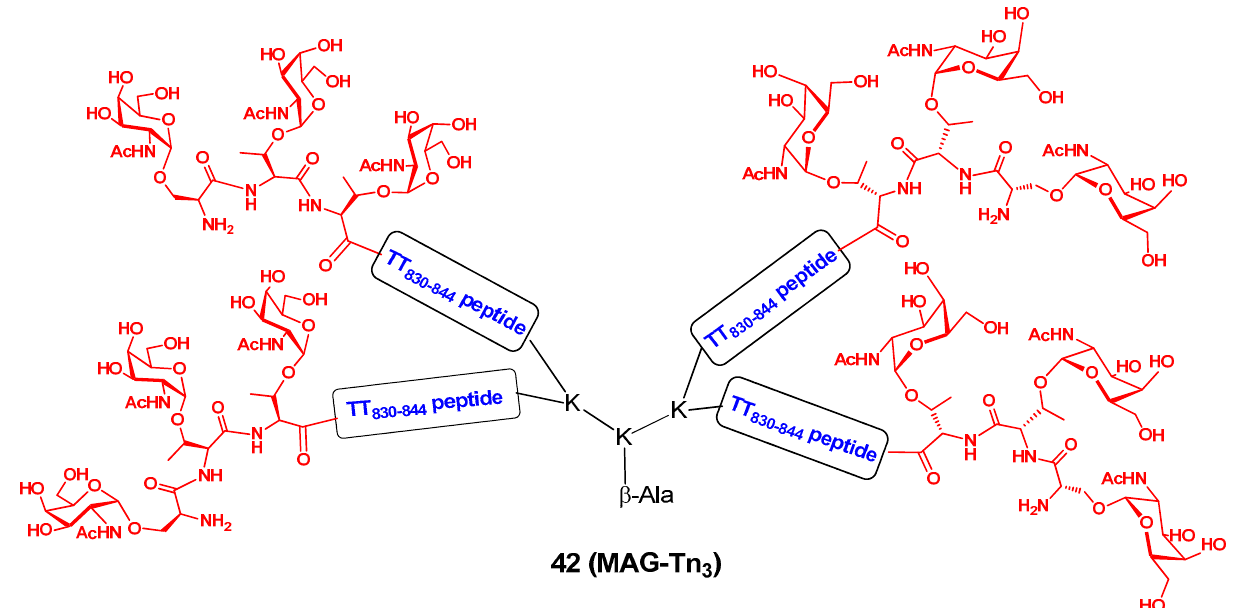
Figure 3. Tetrameric heterofunctional breast cancer vaccine ( 42-MAG-Tn3 ) mounted on L-lysine scaffold and incorporating a carbohydrate as B-cell epitope ( α -D-GalNAc) and a “universal” peptide sequence extracted from tetanus toxin (TT 830–844 ) serving as a T-cell epitope [50,51].